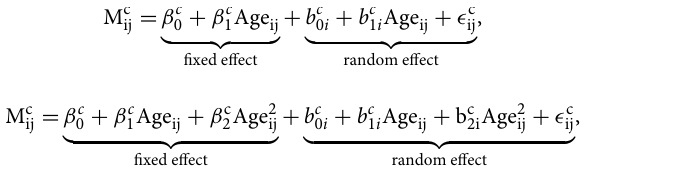
where c denotes the brain region or cognitive test score, M c ij is the measurement of volume of region c or score of cognitive test c for subject i = 1, . . . , N at referral j = 1, . . . , n i . n i is the number of MRI scans or cognitive tests for subject i . Age ij is age of subject i at referral j . Age is the only predictor variable in the mixed model. The β c 0 , β c 1 , and β c 2 are fixed effect parameters while b c 0 i , b c 1 i , and b c 2 i are random effect parameters. ǫ c ij denotes the random residual errors. For constructing the mixed effects models we used the mixedlm function from the statsmodels Python library (v. 0.9.0). For each cognitive and MRI measure we derived the following features for each subject: (i) r-slope : the model-based random effects slope, thus taking the cohort effects for all subjects, and duration of study for each individual into account (the slope of the red lines in Fig. 3a). For both the linear model (Eq. 1) and the quadratic mixed models (Eq. 2), r-slope is b c 1 i , but for the Eq. 2 we used the coefficient of the quadratic term, b c 2 i , as an additional feature. (ii) dev : the distance (deviance) between the random effect line and the fixed effect line at the first time point ( M i1 − (β 0 + β 1 Age i1 ) ), thus taking the results at entry point into account (green dashed lines in Fig. 3a); (iii) d-slope : the slope obtained by dividing the difference of the measure at the first and last measurements by the duration between them, i.e. the slope of change from the first to the last